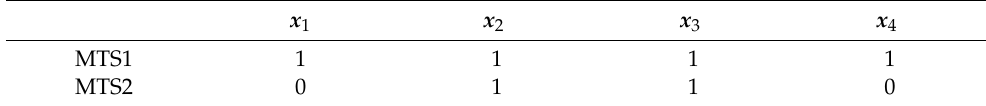
Table 3. Feature variable selection results of the Optimized BT-MTS of the balance data set.